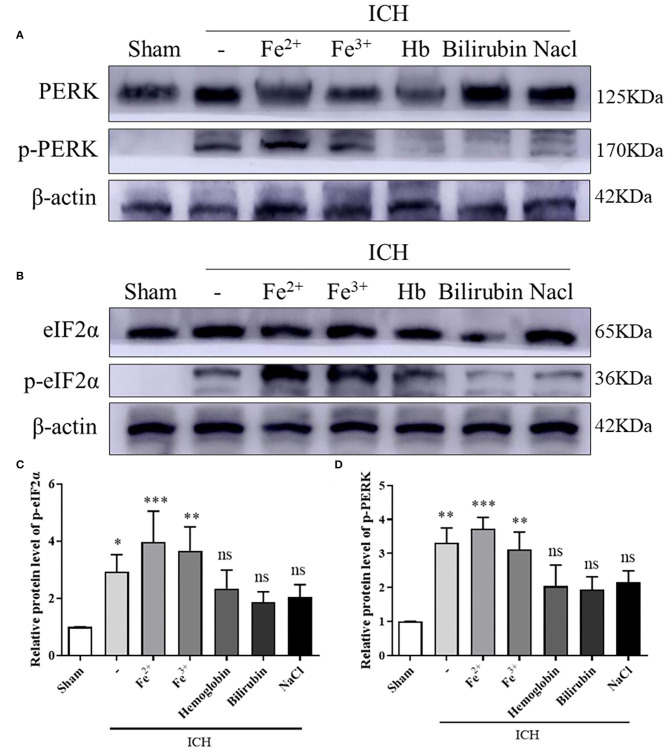
PERK/p-PERK and eIF2α/p-eIF2α protein amounts in peri-injury cortex following ICH. WB analysis and quantification of p-PERK (A,C) and p-eIF2α (B,D) protein amounts in ICH caused by whole blood, FeCl3, FeCl2, hemoglobin(Hb), bilirubin, and saline in brain tissues. The Sham group was used for normalization, and quantitation used ImageJ. Data was mean ± SD (n = 4). *p < 0.05, **p < 0.01, ***p < 0.005, nsp > 0.05 vs. Sham.